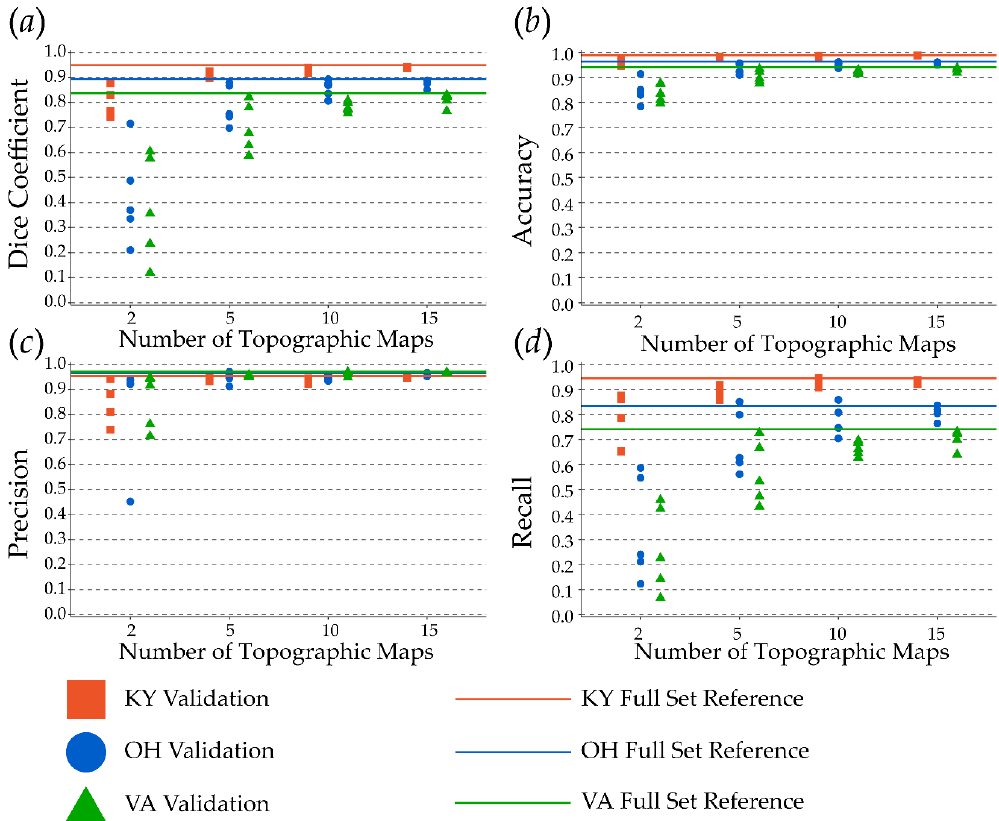
Figure 11. Comparison of model performance for predicting validation datasets with a changing number of training topographic maps and chips. Solid lines represent the results obtained when using the full training dataset, or all KY Training topographic maps and associated chips. ( a ) Dice coefficient or F1 score, ( b ) overall accuracy, ( c ) precision, and ( d ) recall.